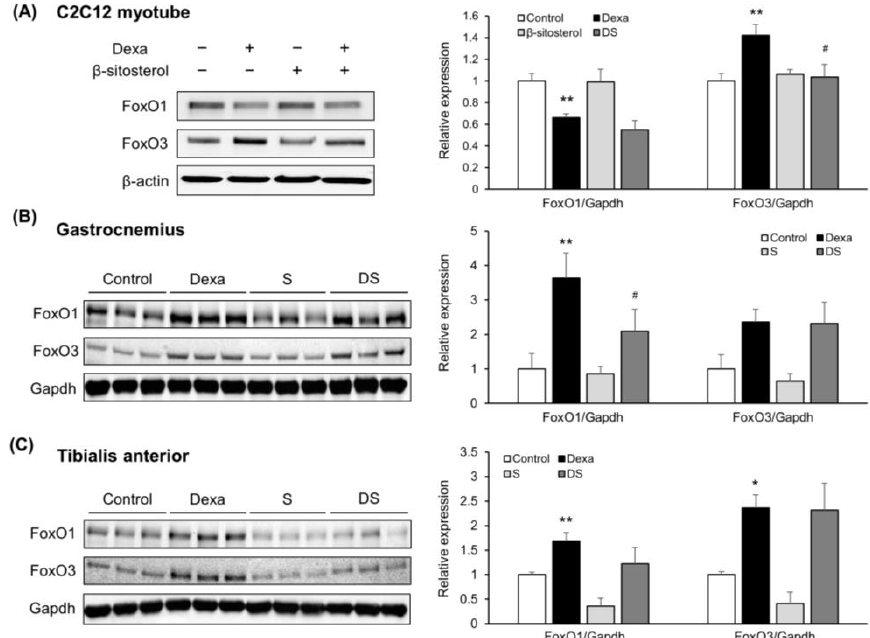
Figure 5. β -sitosterol inhibits Dexa-induced atrophy in C2C12 myotube and mice via FoxO1/3- dependent signaling. ( A ) Representative images of the Western blot analyses for FoxO1 and FoxO3 in C2C12 myotube. Right panel show quantification of the indicated proteins. Data shown are mean ± S.D. ( n = 3 per group). ** p < 0.01 vs. control; # p < 0.05 vs. Dexa. ( B ) Representative images of the Western blot analyses for FoxO1 and FoxO3 in gastrocnemius muscles. Right panel show quantification of the indicated proteins. Data shown are mean ± S.D. ( n = 3 per group). ** p < 0.01 vs. control; # p < 0.05 vs. Dexa. ( C ) Representative images of the Western blot analyses for FoxO1 and FoxO3 in tibialis anterior muscles. Right panel show quantification of the indicated proteins. Data shown are mean ± S.D. ( n = 3 per group). ** p < 0.01; * p < 0.05 vs. control. Dexa — Dexamethasone; S —β -sitos- terol; DS — dexa + β -sitosterol.